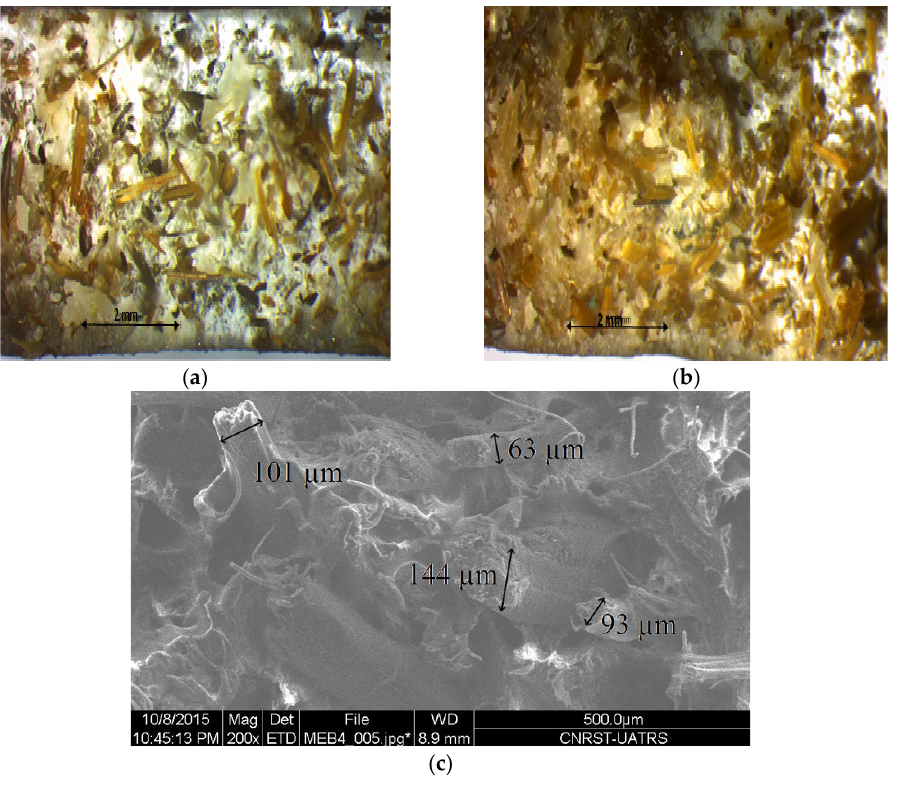
Figure 5. Images of the PP/alfa specimens: ( a ) with a binocular microscope for PP/alfa (20%) and ( b ) PP/alfa (30%); ( c ) with a scanning electron microscope for PP/alfa (30%).